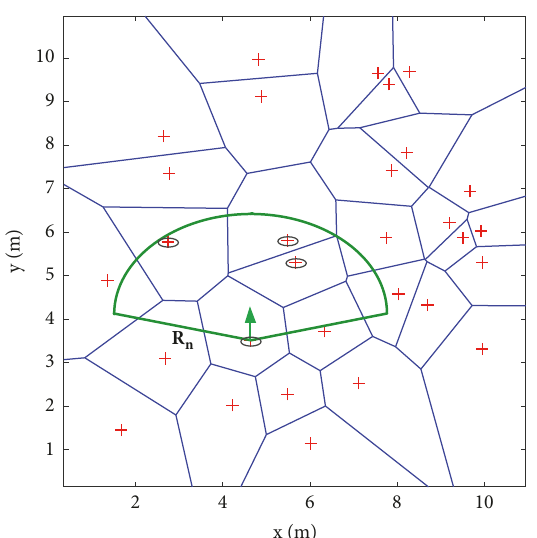
Figure 4: Illustration of density calculation using the Voronoi diagram.